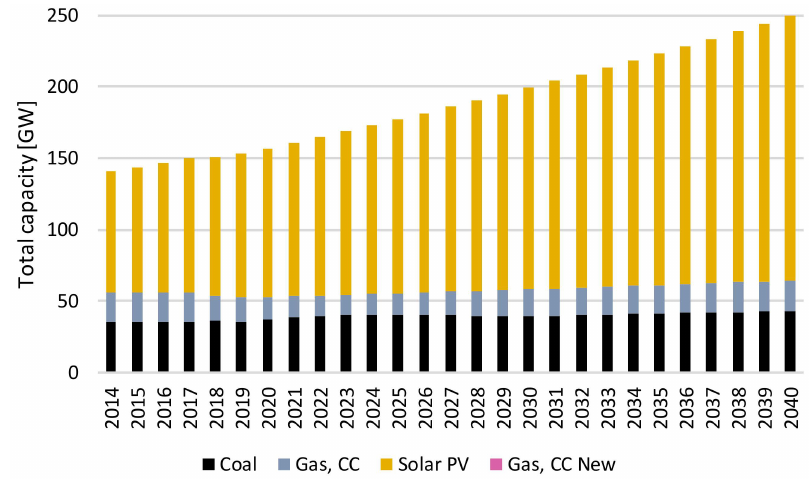
Figure 4. Total capacity (GW) in the RETarget scenario—without code